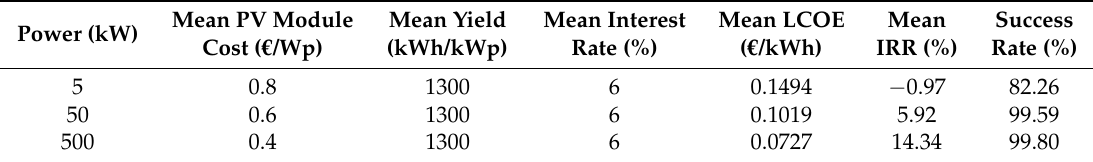
Table 17. Summary of the means of IRR and LCOE extracted from the Monte Carlo method for all the